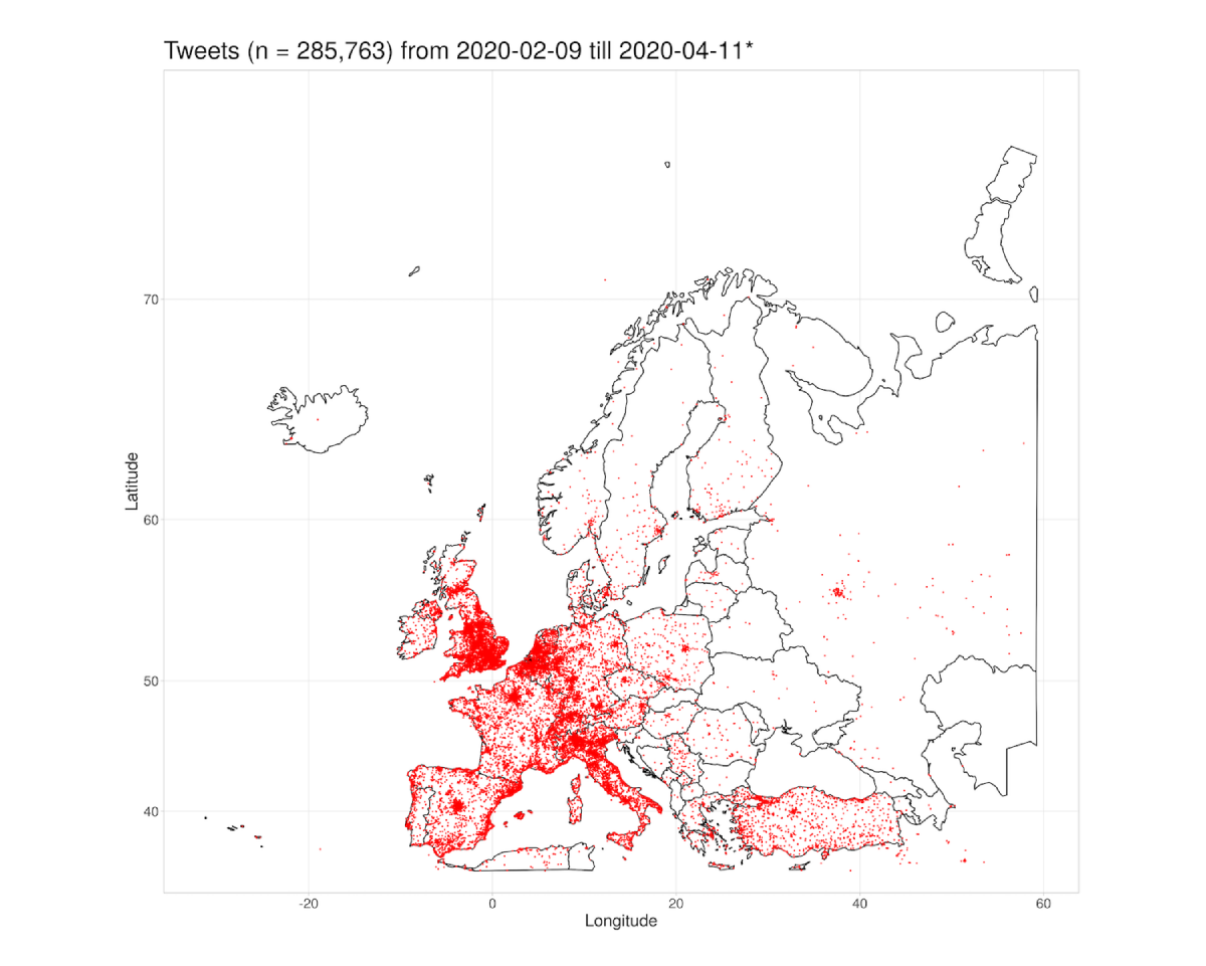
Figure 5. Cumulative depiction of all tweets in European countries between February 9 and April 11, 2020. Each red dot denotes one tweet. Tweets with the same geographical information are plotted on top of each other. *No tweets were collected between February 20, 2020, and February 22, 2020, and between March 28, 2020, and March 29, 2020, due to technical